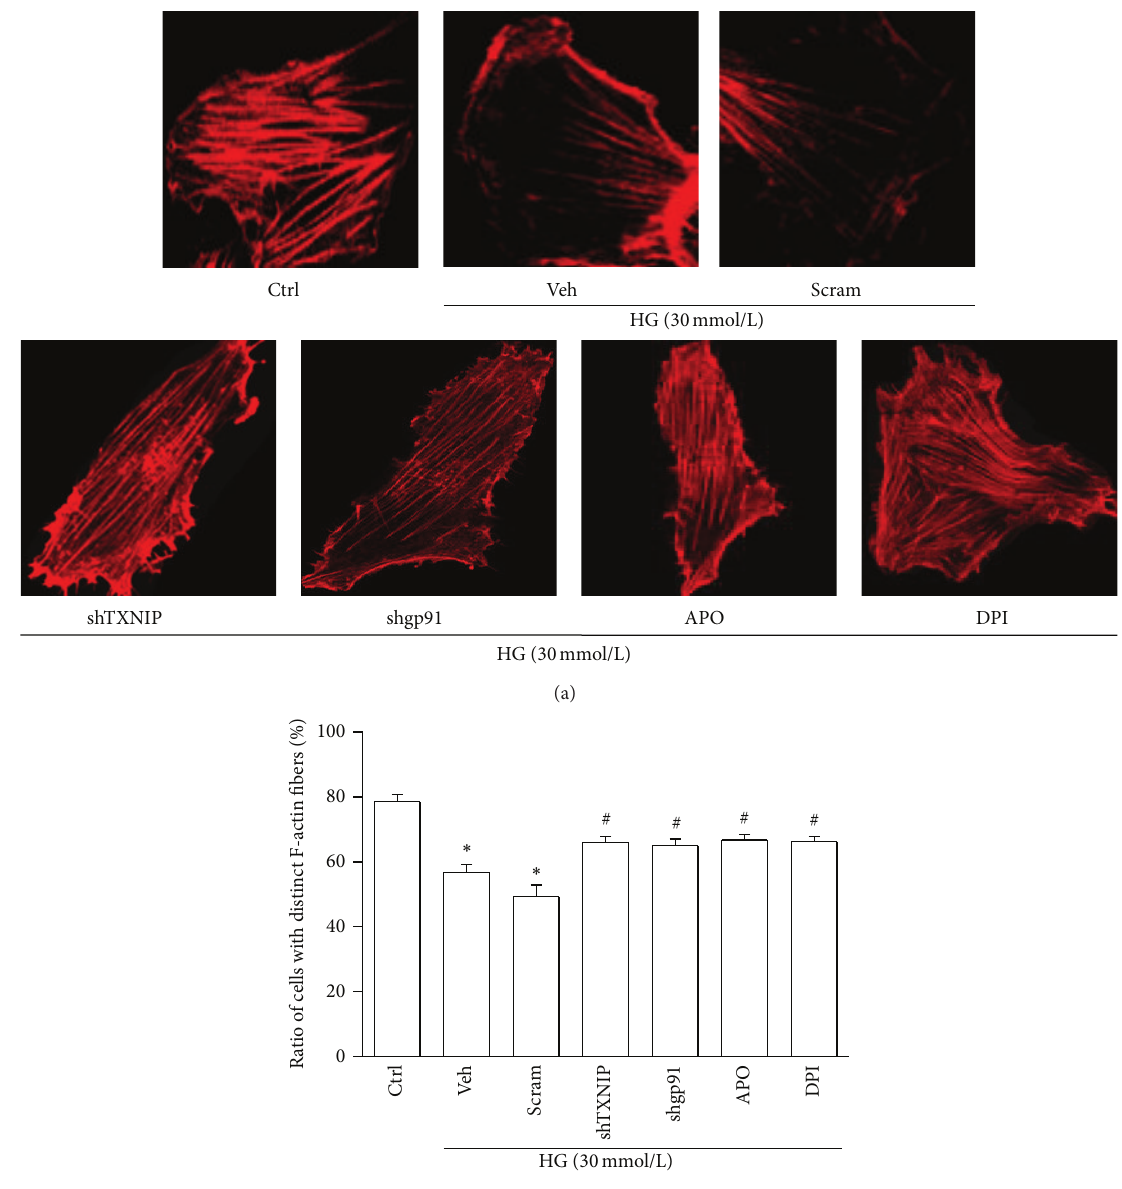
Figure 7: Inhibiting either TXNIP or NADPH oxidase partially preserves the arrangement of F-actin fibers in podocytes exposed to HG. (a) Microscopic images of F-actin by rhodamine-phalloidin staining. (b) Summarized data from counting the cells with distinct, longitudinal F- actin fibers. Scoring was determined from 100 podocytes on each slide ( 𝑛 = 5 ). Ctrl: control; HG: high glucose; Veh: vehicle; Scram: scrambled shRNA; shTXNIP: TXNIP shRNA; shgp91: gp 91 𝑝ℎ𝑜𝑥 shRNA; APO: apocynin; DPI: diphenyleneiodonium. ∗ 𝑃 < 0.05 compared with Ctrl; # 𝑃 < 0.05 compared with HG group treated with vehicle or transfected with scramble